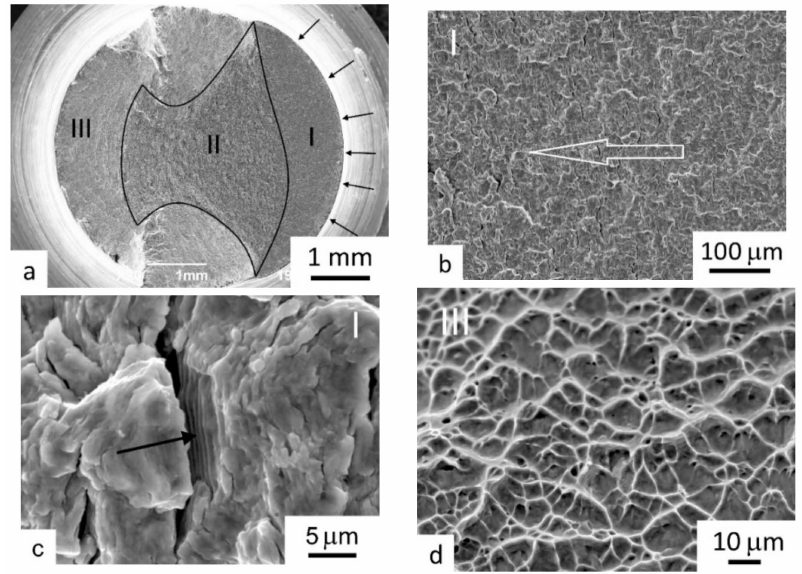
Figure 10. SEM images of the fracture surfaces of the CG alloy samples after tests at a stress of 750 MPa: ( a ) general view of the fracture surface, the black arrows showing the origins; ( b ) zone of stable crack propagation (zone I), white arrow shows the direction of growth of the main crack; ( c ) fatigue striations in zone I (arrow); ( d ) dimple relief in the final rupture zone.